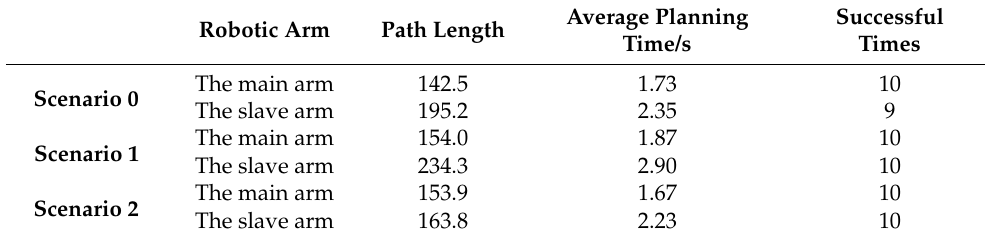
Table 5. Simulation results in different obstacle